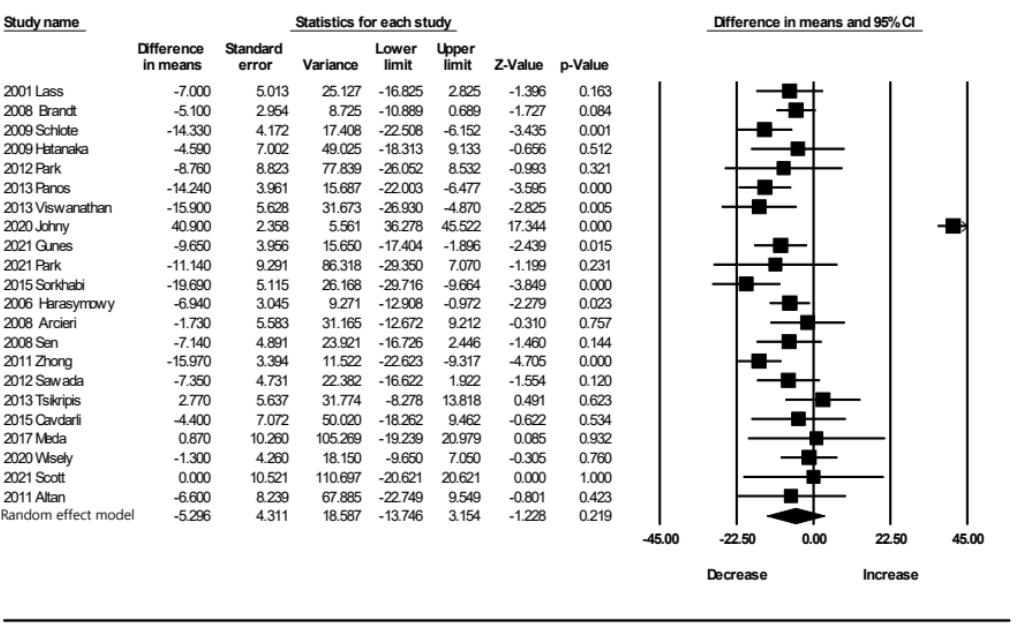
Figure 2. Single ‐ arm meta ‐ analysis of CCT change after topical prostaglandin analogue treatment. Figure 2. Single-arm meta-analysis of CCT change after topical prostaglandin analogue